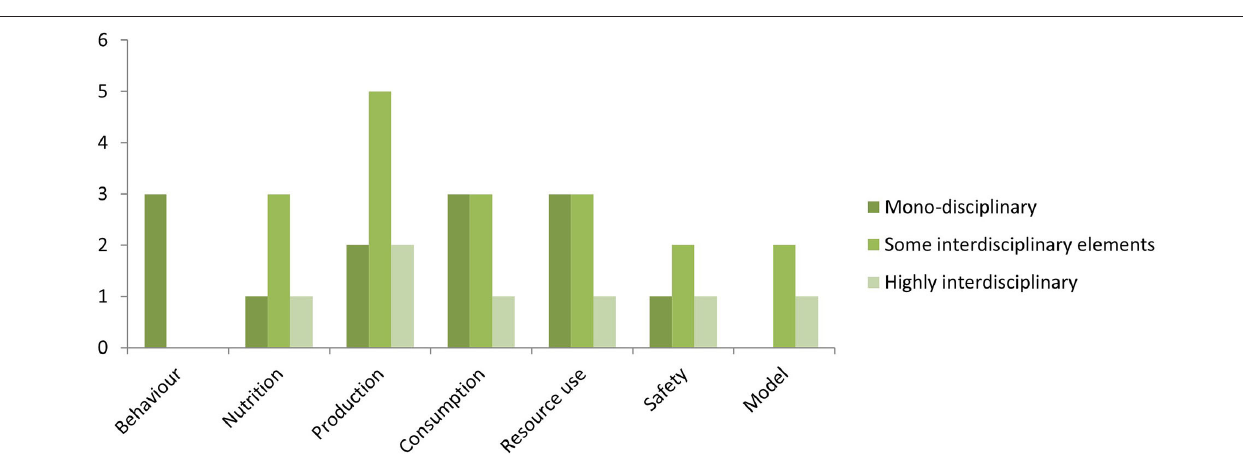
FIGURE 7 | Level of interdisciplinarity, by